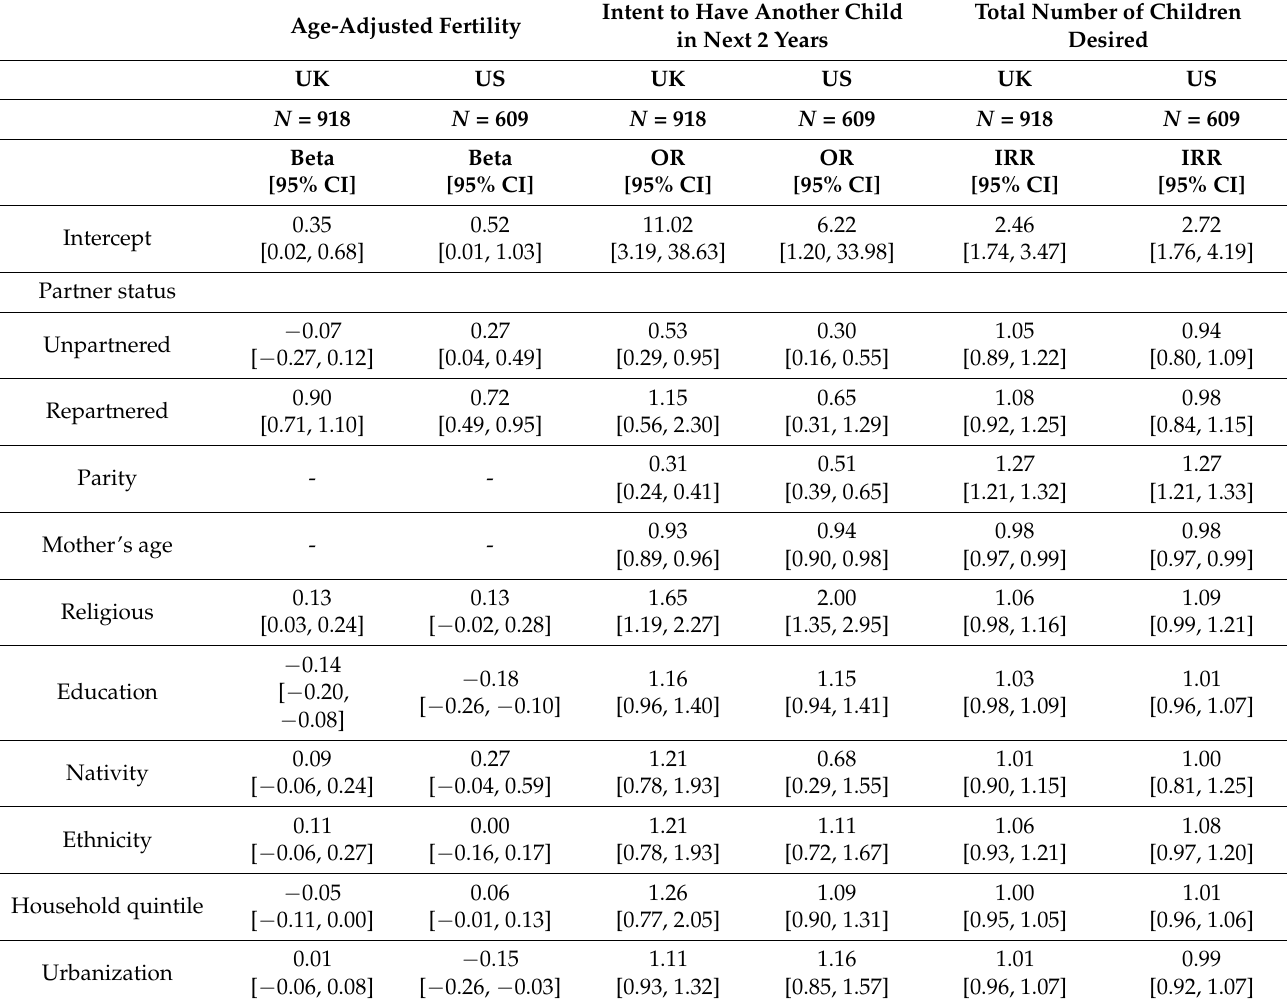
Table 5. Results of Bayesian regression models predicting fertility outcomes in the US and in the UK. Intent to Have Another Child Total Number of Children Age-Adjusted Fertility in Next 2 Years